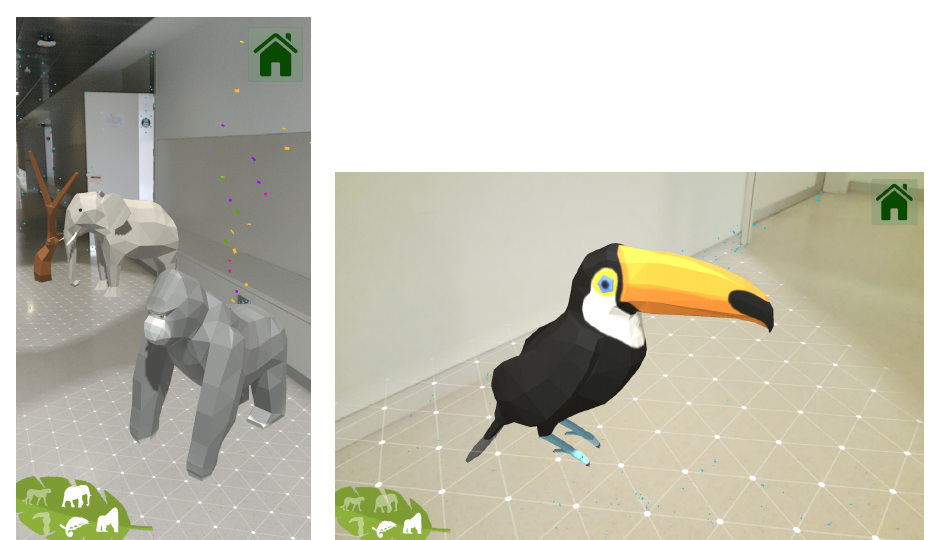
Figure 9. Screenshots from the “Jungle adventure” game.